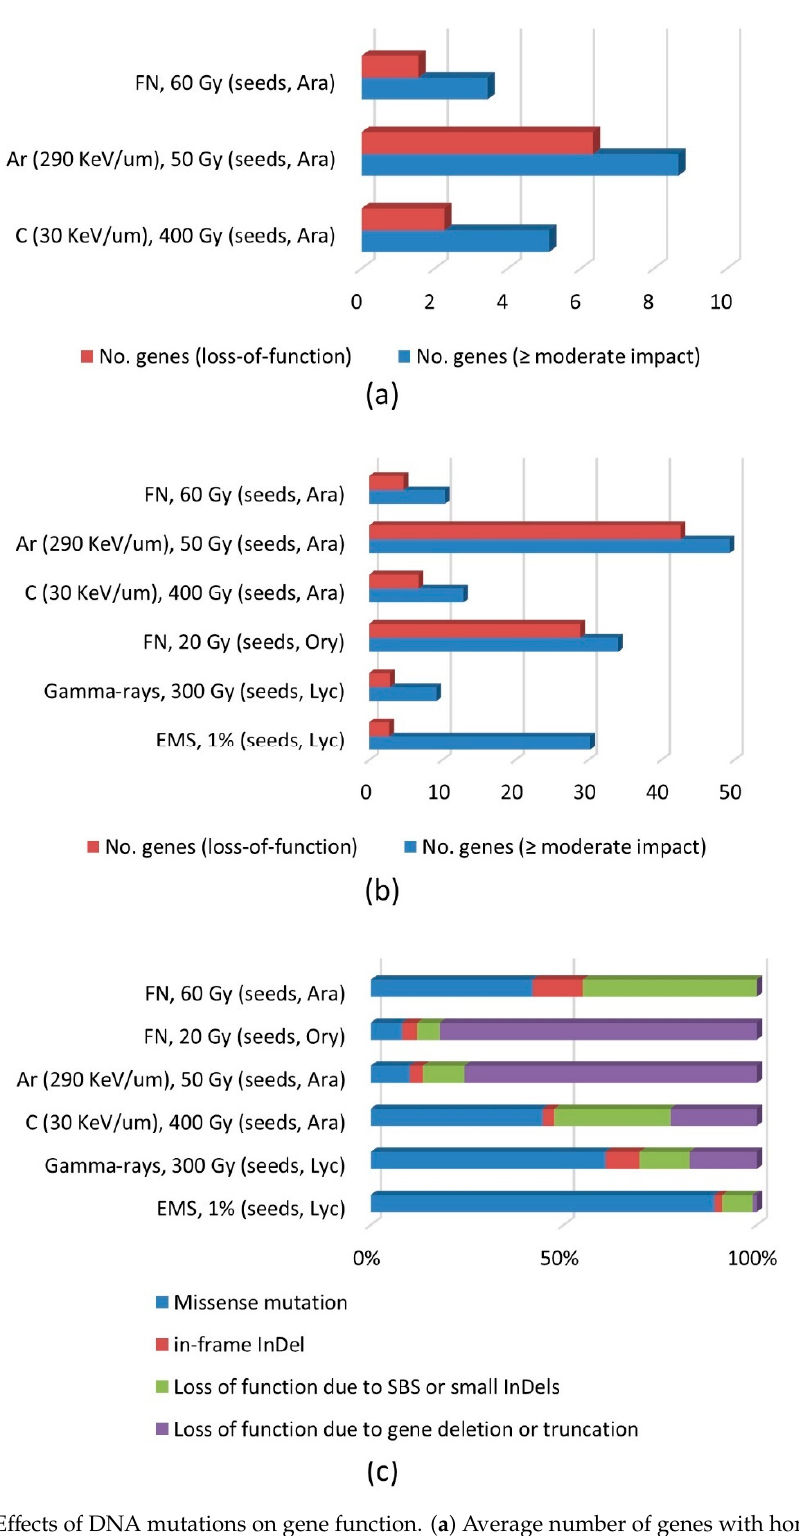
Figure 3. E ff ects of DNA mutations on gene function. ( a ) Average number of genes with homozygous mutations estimated for the M 2 generation. ( b ) Average number of genes with homozygous or heterozygous mutations estimated for the M 2 generation. ( c ) Classification of mutations according to their e ff ects on gene function. Only studies that provided enough information for analyses were included. Regarding the argon beam irradiation (290 KeV µ m − 1 ), the data from Hirano et al. [11] were used in the analysis because one mutant line included in the study by Kazama et al. [12] contained extraordinarily long deleted sequences and included 852 genes.